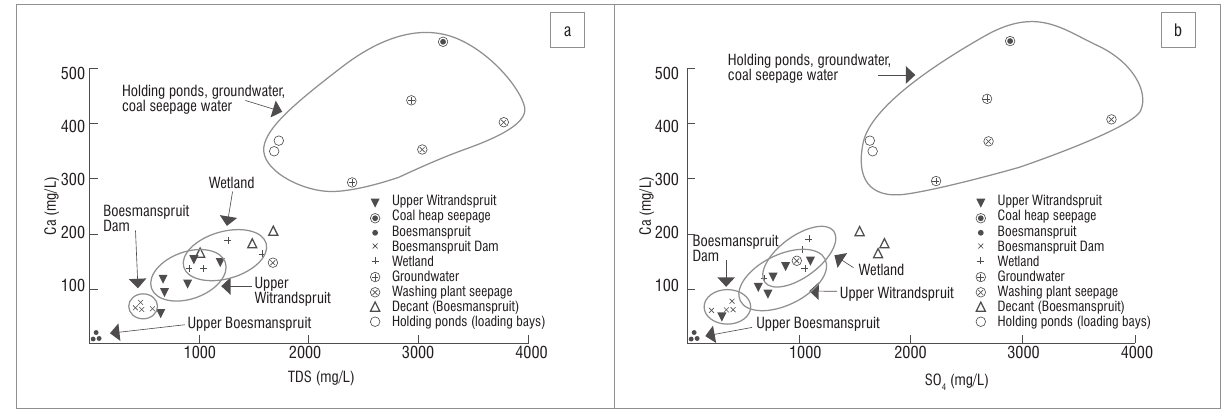
) for water samples from the Boesmanspruit 4